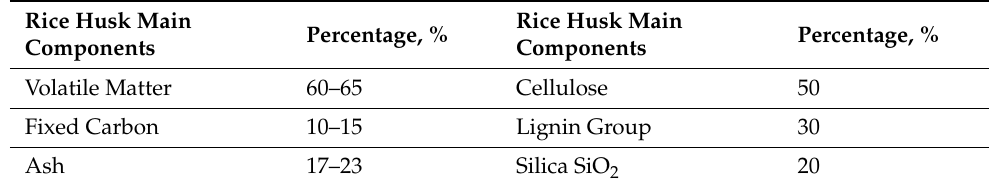
Table 1. The main constituents of RH in %. Reprinted with permission from Ref. [2]. Copyright 2018,